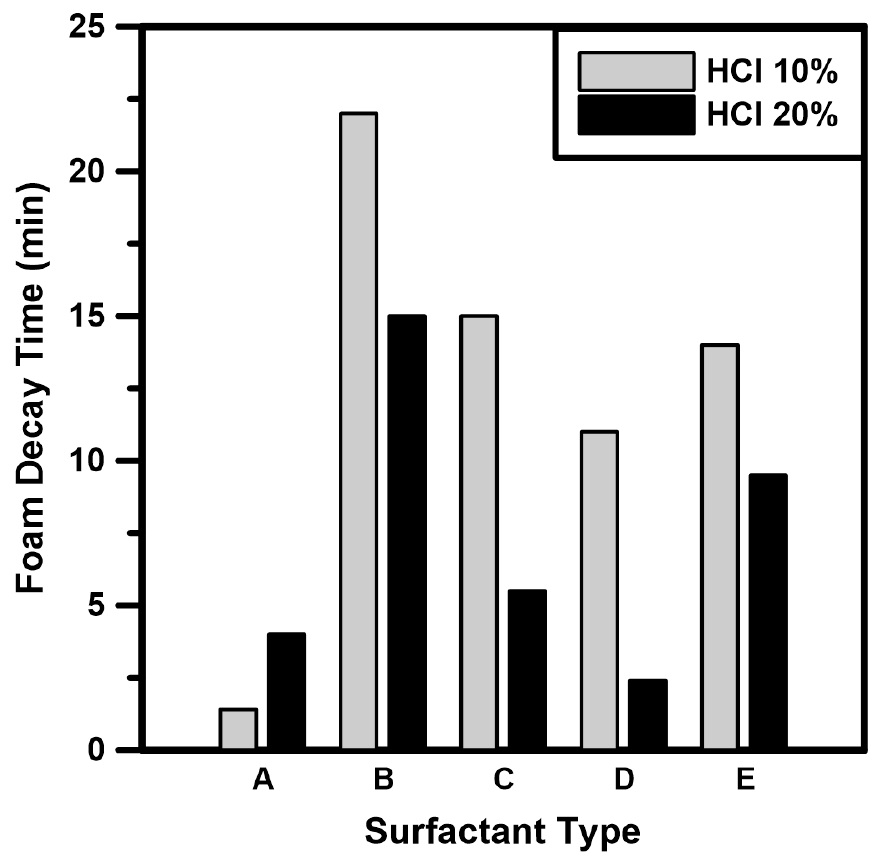
Figure 3. Foam decay time of various surfactants under atmospheric conditions.